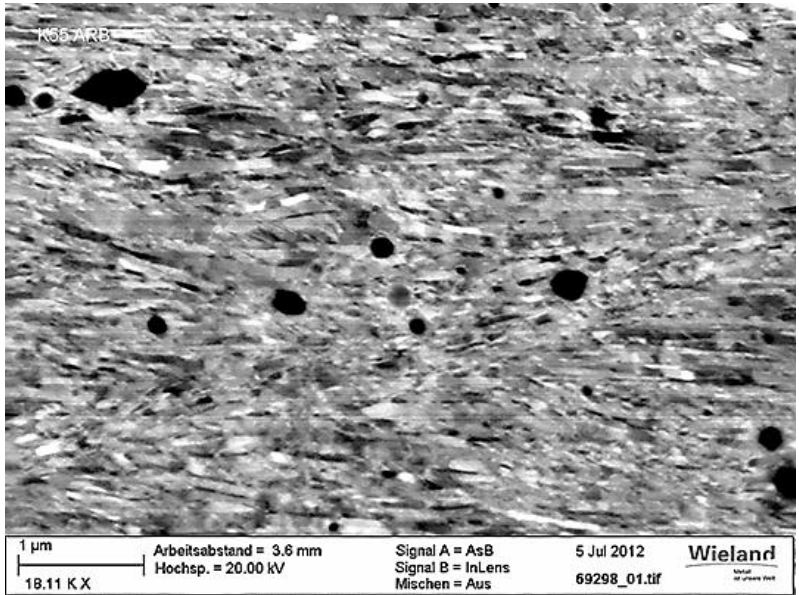
Figure 11. Microstructure of solution treated ARB-processed CuNi3Si1Mg. The larger precipitates were not dissolved by the solution treatment and are remains from the prematerial as produced by continuous